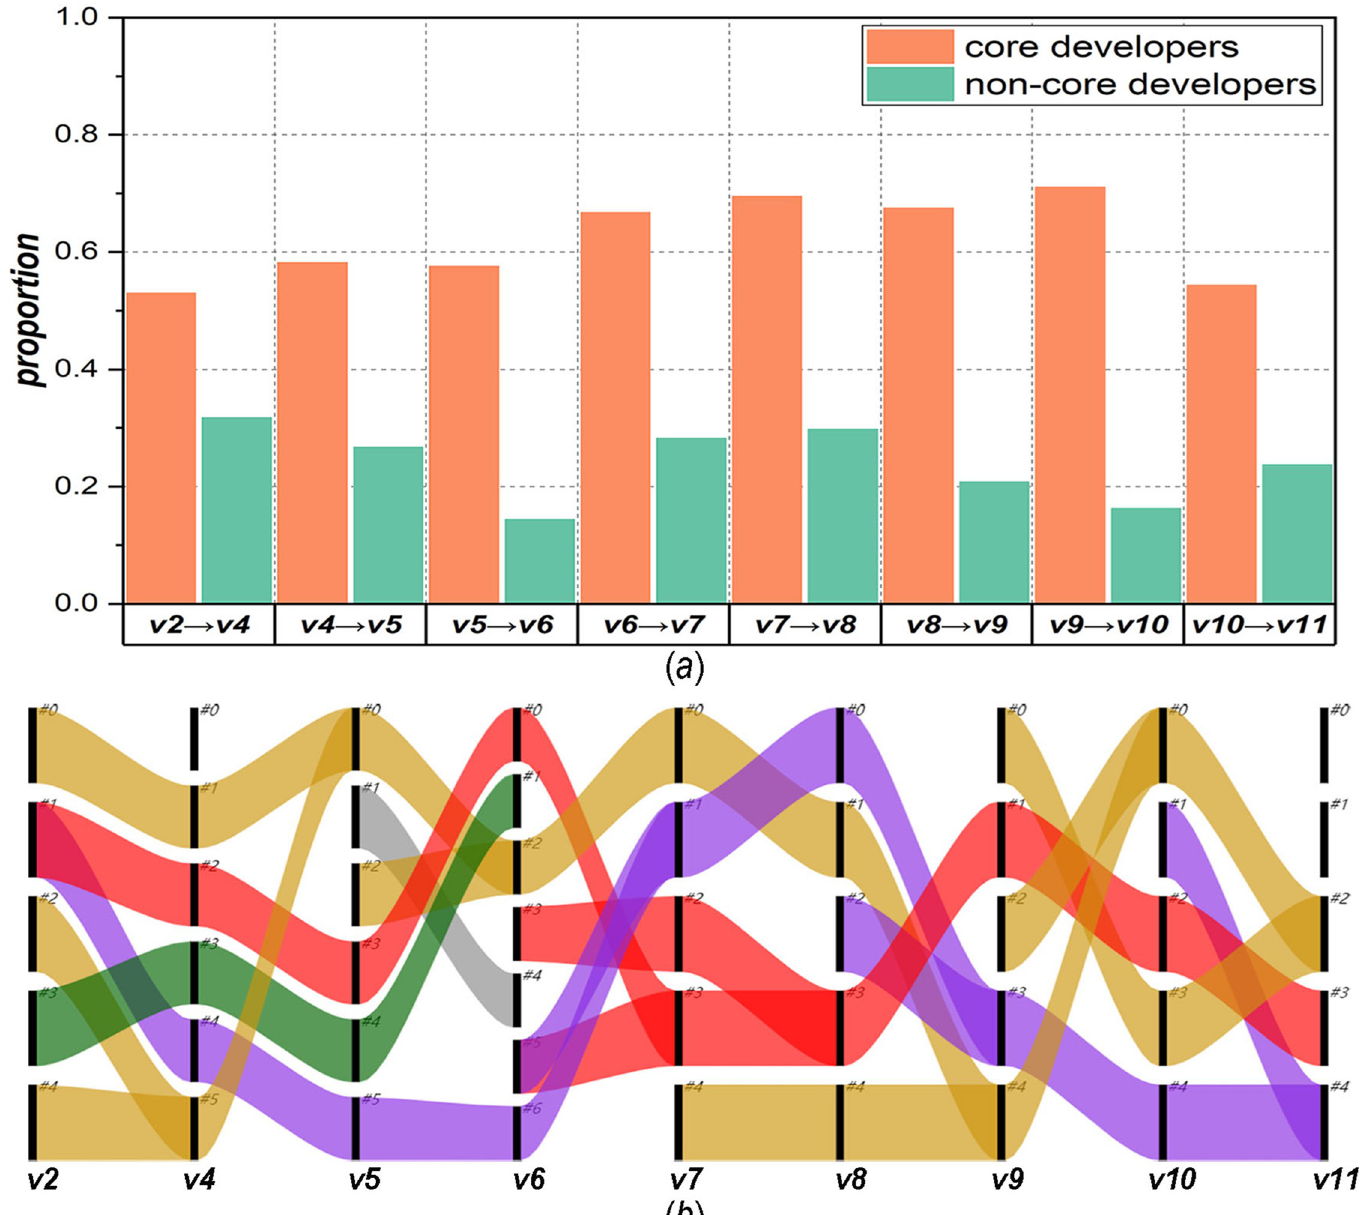
Fig 10. Changes in core nodes during network evolution, (a) retention proportion of core and noncore nodes, (b) evolution of core nodes. https://doi.org/10.1371/journal.pone.0270922.g010 Taking network v 5 as a representative example, Fig 12 summarizes the maintenance role of core nodes (i.e., hubs and connectors) in network structure integration. Each module contains a small number of core nodes (the nodes in the dashed circle), and these core nodes are tightly connected to form the cohesive core of the network (as shown in the subgraph). Correspond- ingly, the modular small-world structure of the network is formed centred on such a core. More than half of the inner-module links are participated in by the hubs (the nodes marked with “H”), indicating the module organizing role of hubs. The connectors (the nodes marked